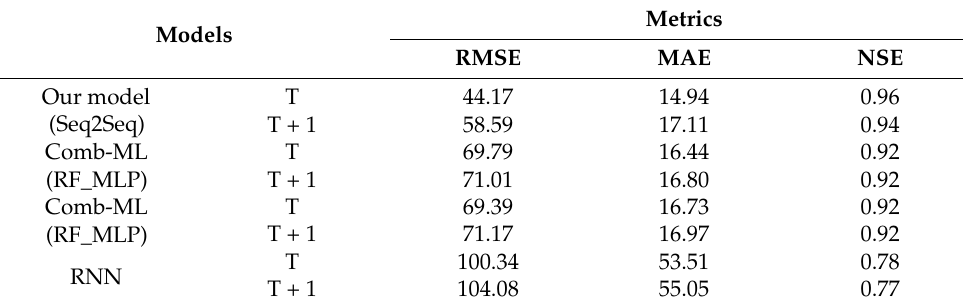
Table 15. Prediction accuracy result of the proposed model, Comb- ML and